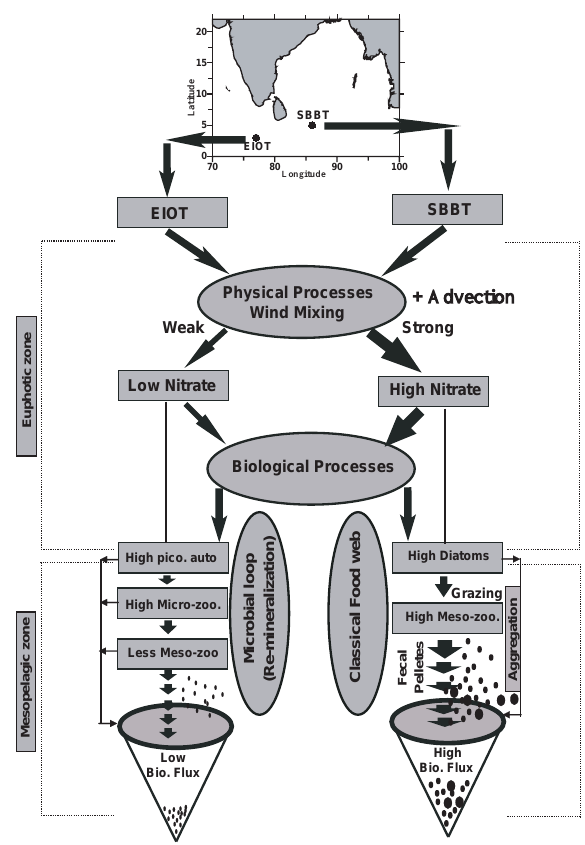
Fig. 14. Schematic picture summarising the physical and biological processes starting from production of organic carbon in the upper ocean to its export into the deep ocean as captured by the sediment trap at SBBT and EIOT (see text for